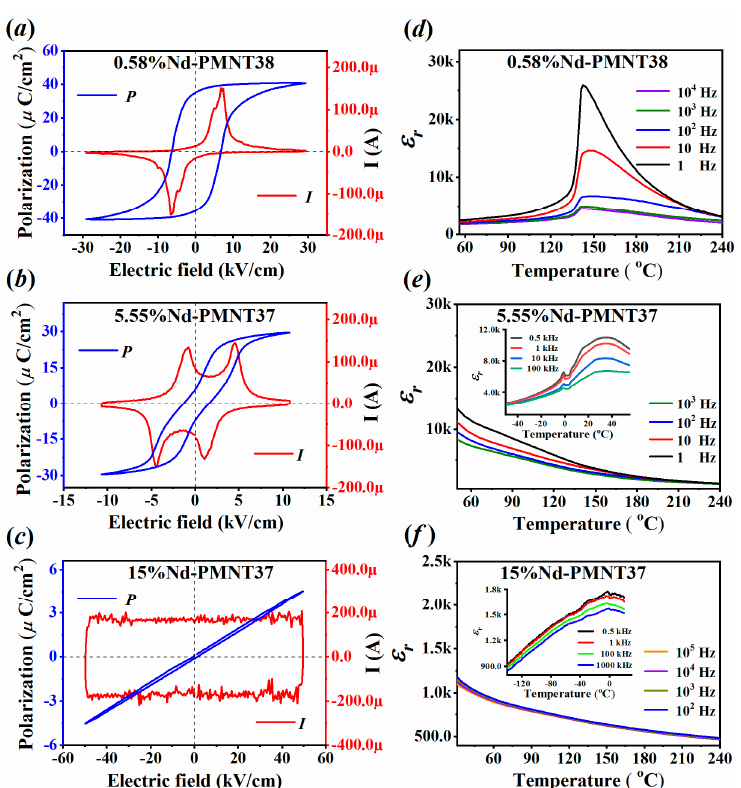
Figure 3. The polarization–electric field ( P - E ) hysteresis loops and the current–electric field ( I - E ) curves of ( a ) 0.58%Nd-PMNT38, ( b ) 5.55%Nd-PMNT37 and ( c ) 15%Nd-PMNT37 single crystals at room temperature (2 Hz). The temperature dependence of dielectric constant ε r for ( d ) 0.58%Nd-PMNT38, ( e ) 5.55%Nd-PMNT37 and ( f ) 15%Nd-PMNT37 single crystals.